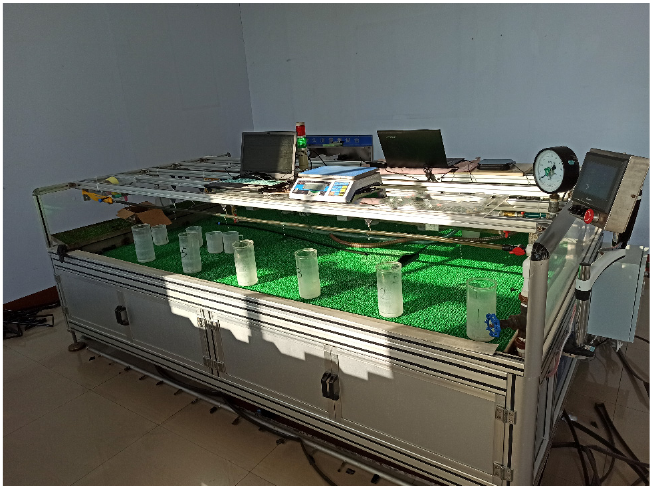
Figure 6. Laboratory experimental platform for measured emitter discharge.